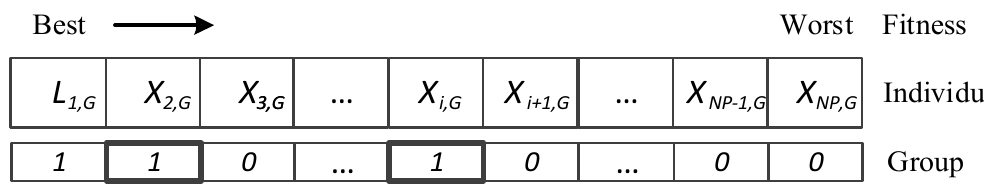
Figure 6. The first group leader with the highest fitness value.